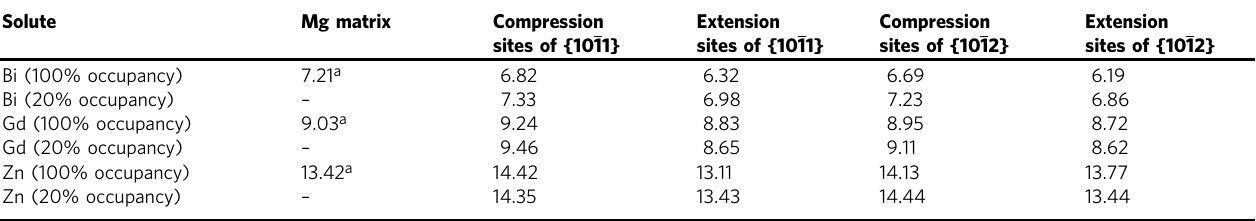
Table 1 Bader charge values ( e ) of Bi, Gd, and Zn atom located in Mg lattice and occupying compression or extension sites in a CTB. The cases of 20% occupancy by Bi and Gd are also listed.